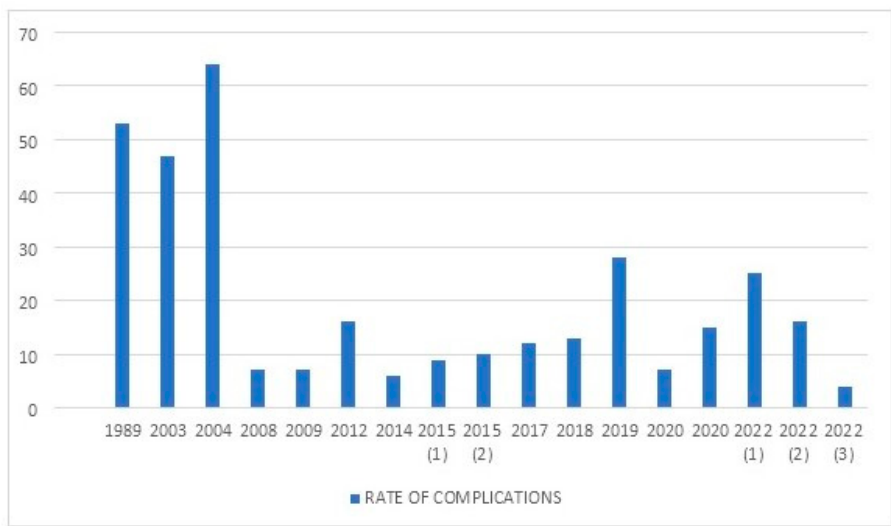
Figure 1. Rates of complications of total knee arthroplasty (TKA) in people with hemophilia (PWH) from 1989 to 2022. In 2015 there were two articles ((1) and (2)), while in 2022 there were three articles ((1)–(3)).